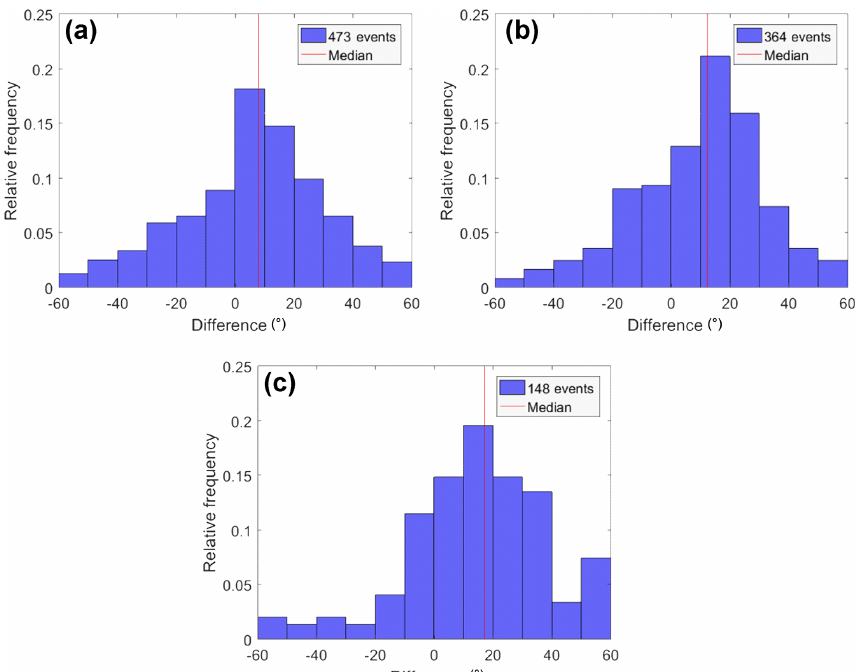
Figure 13. Histograms of HS events showing the relative frequency of the differences in the propagation direction between the storm motion vectors c and the wind in 500hPa from ERA-Interim at the location and time of the HS events for three different diameter categories: (a) D < 3cm, (b) 3 ≤ D < 5cm, and (c) D ≥ 5cm. Median values are indicated by the red